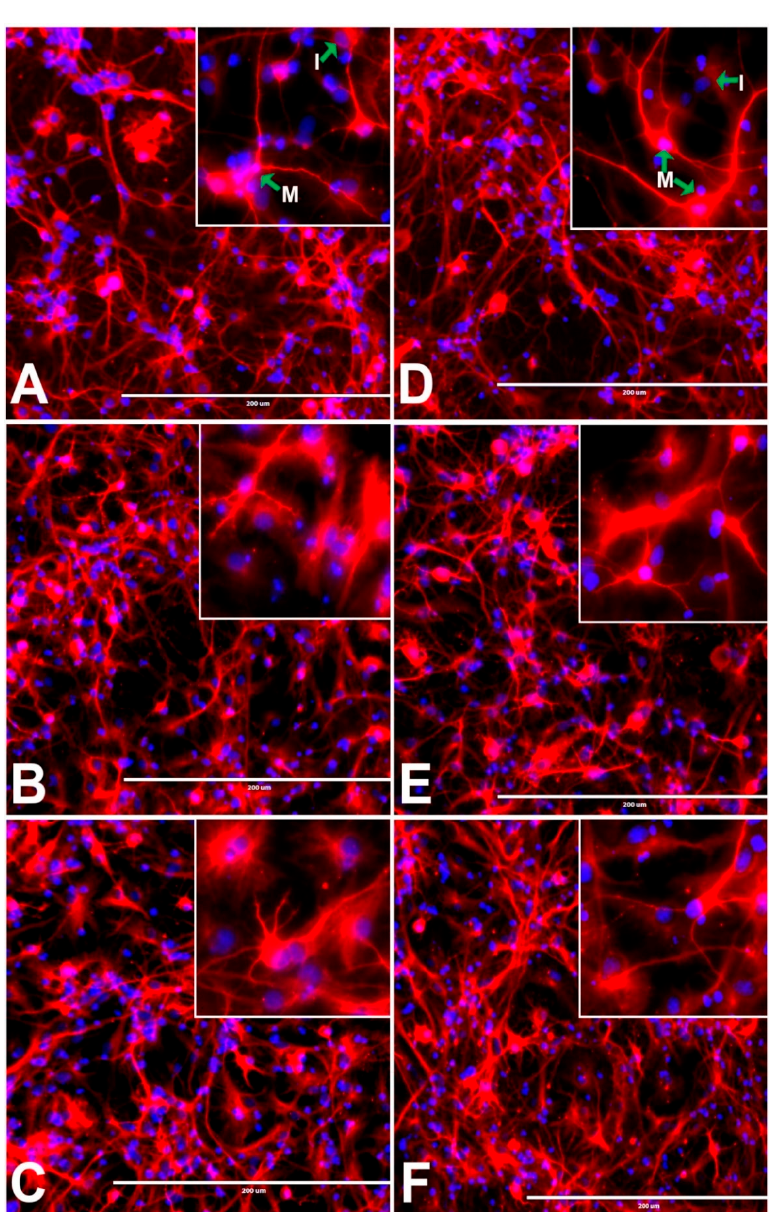
Figure 3. Effects of different doses of BPA or BPF on the morphological differentiation of rNSCs into neurons. rNSCs grown in neuron directed-differentiation media in the absence or presence of BPA or BPF for a seven day period. Differentiated neurons were visualized with specific neuronal protein- marker MAP2 and nuclei marker DAPI. The images shown are representative fluorescent-images of differentiated neurons ( A ) without BPA (control), ( B ) with 50 µ M of BPA, ( C ) with 100 µ M of BPA; ( D ) without BPF (control), ( E ) with 50 µ M of BPF, and ( F ) with 100 µ M of BPF. Arrows indicate mature neurons with characteristic morphology ( M ) and immature neurons without characteristic morphology ( I ). Scale bar indicates 200 µ m at 20 ×